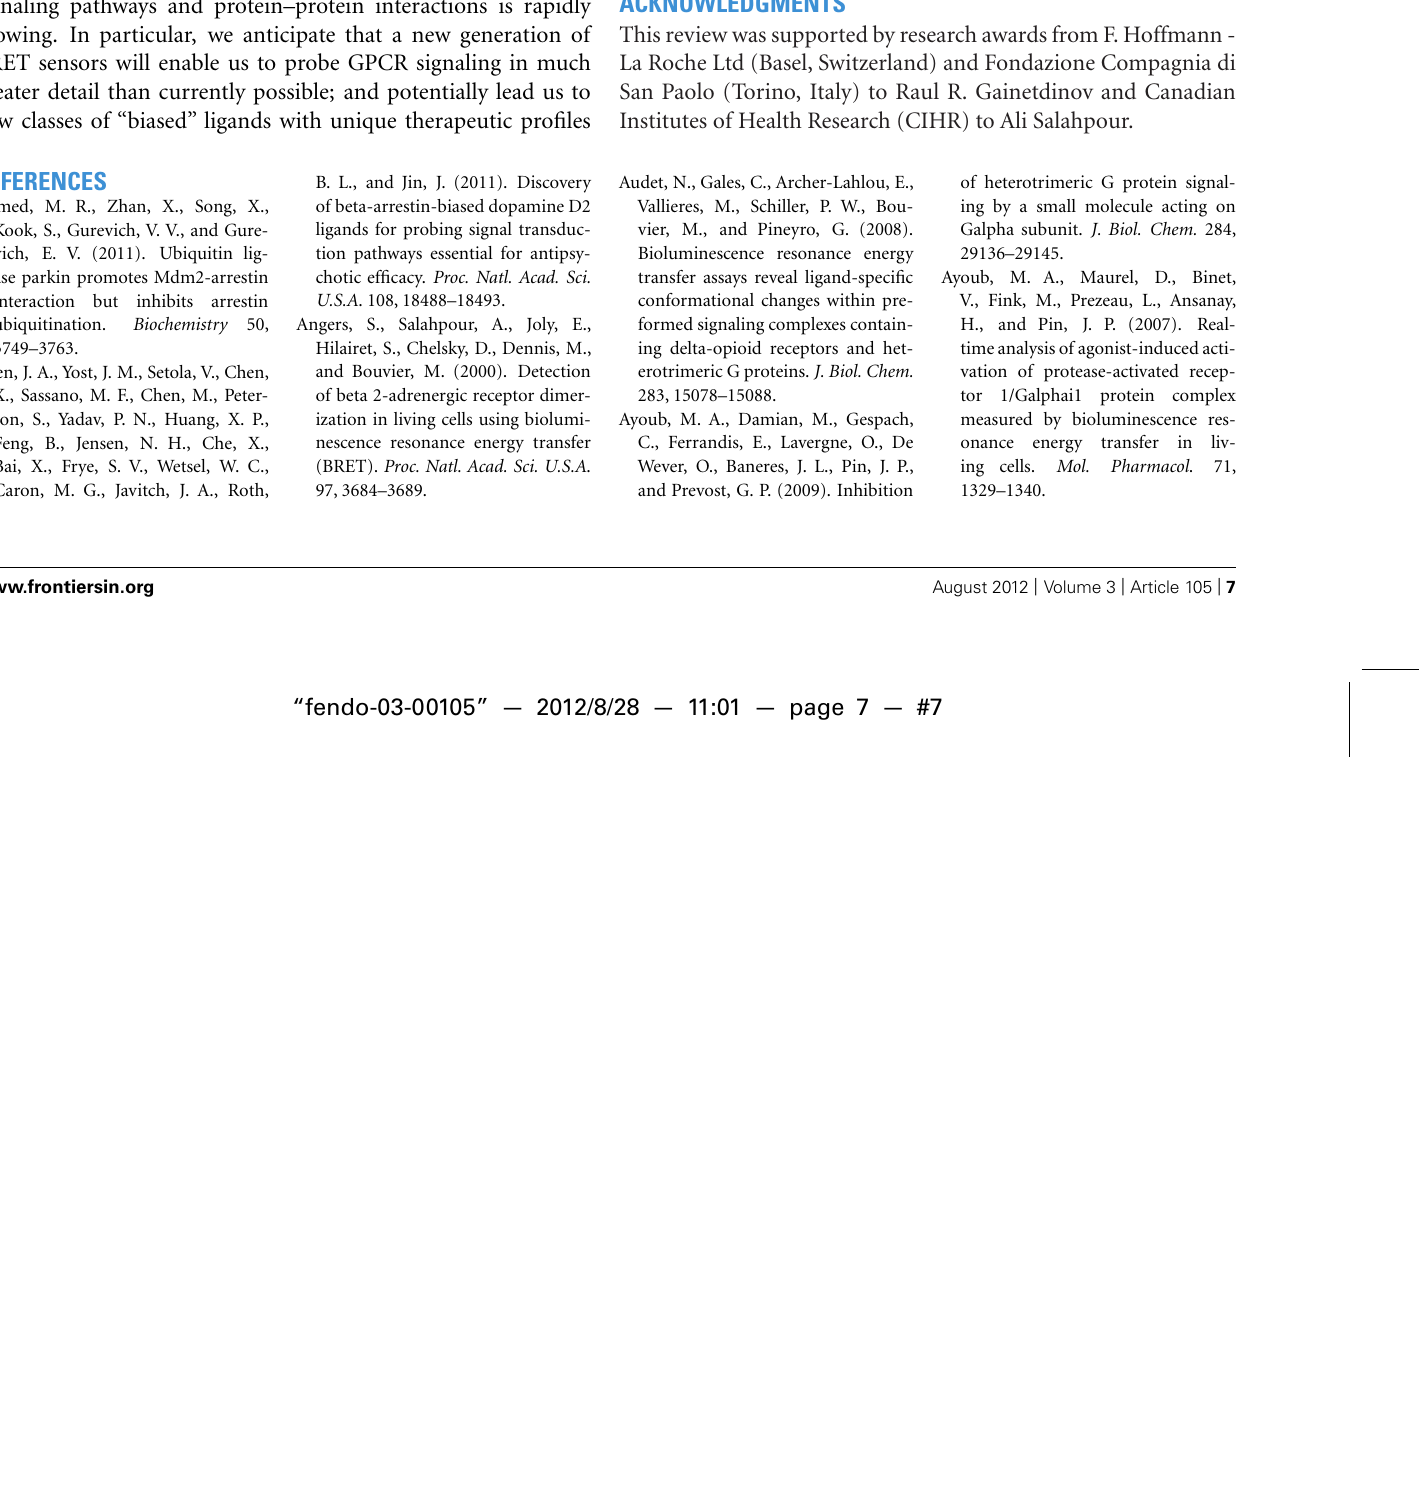
FIGURE 3 | Bioluminescence resonance energy transfer (BRET) monitoring ofTAAR1 and D2R heterodimerization. (A) Cartoon of postulated molecular events during heterodimerization of GPCRs causing related BRET signal.TAAR1 is tagged with Rluc and D2R is tagged with YFP to monitor intermolecular interaction between these two receptors. (B) BRET titration curve of physical interaction betweenTAAR1–Rluc and D2R–YFP. A fixed amount ofTAAR1–Rluc and increasing amount of D2R–YFP were co-expressed in the same cells. BRET was measured